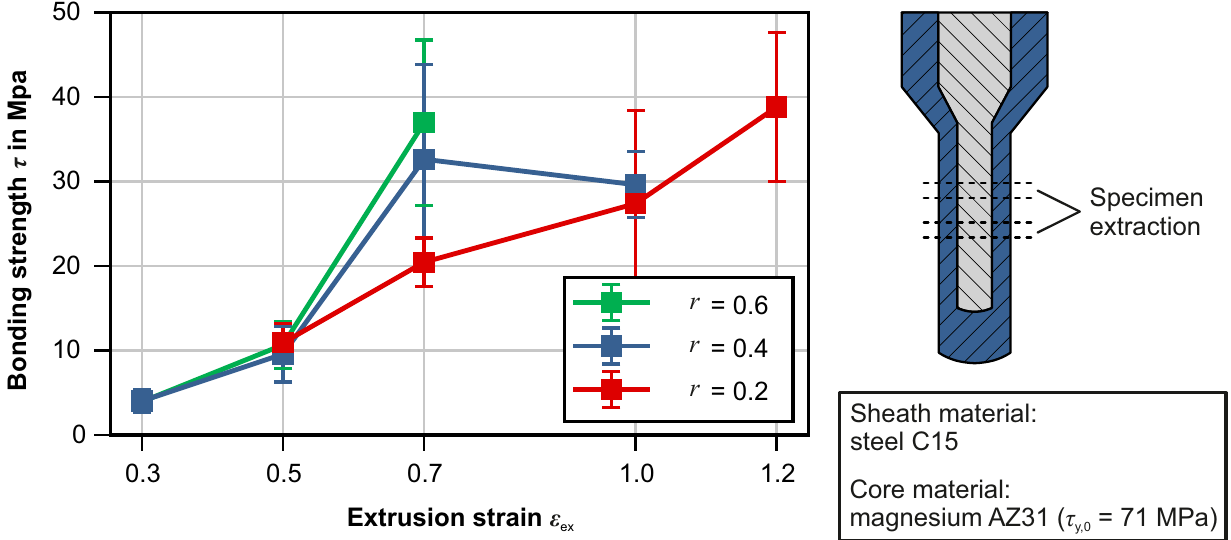
Figure 9. Bond strength of magnesium core and steel sheath, obtained by push-out testing and location of specimen